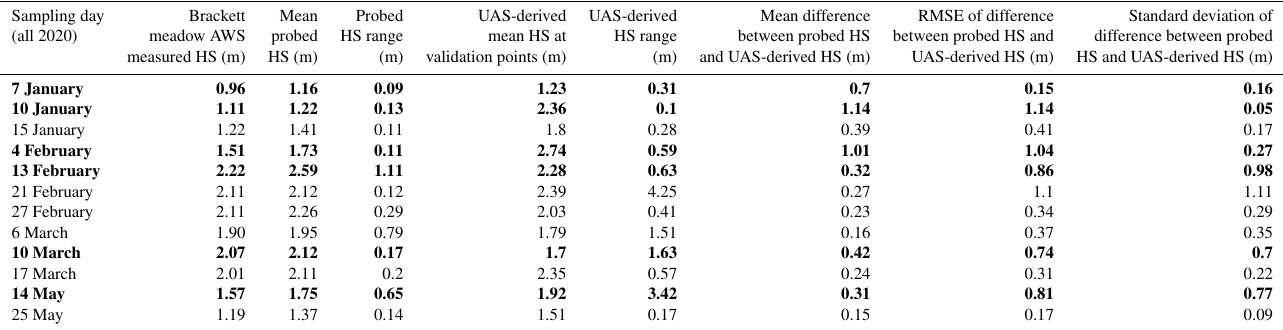
Table A3. Summary of statistics of all measured and uncrewed aerial systems (UAS)-derived snow depths (HS) from the Hourglass and meadow on all sampling days. Low-quality modeled meadow days removed from analysis in bold. All values reported in meters.